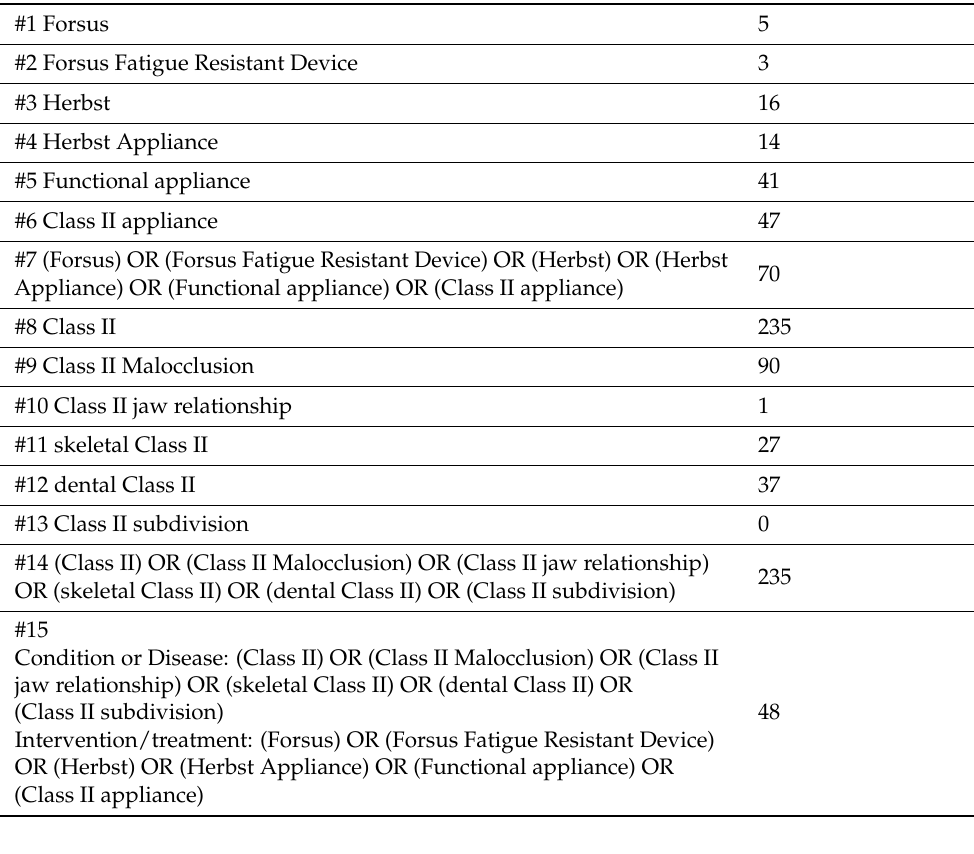
Table A6. Search strategy for ClinicalTrials.gov.